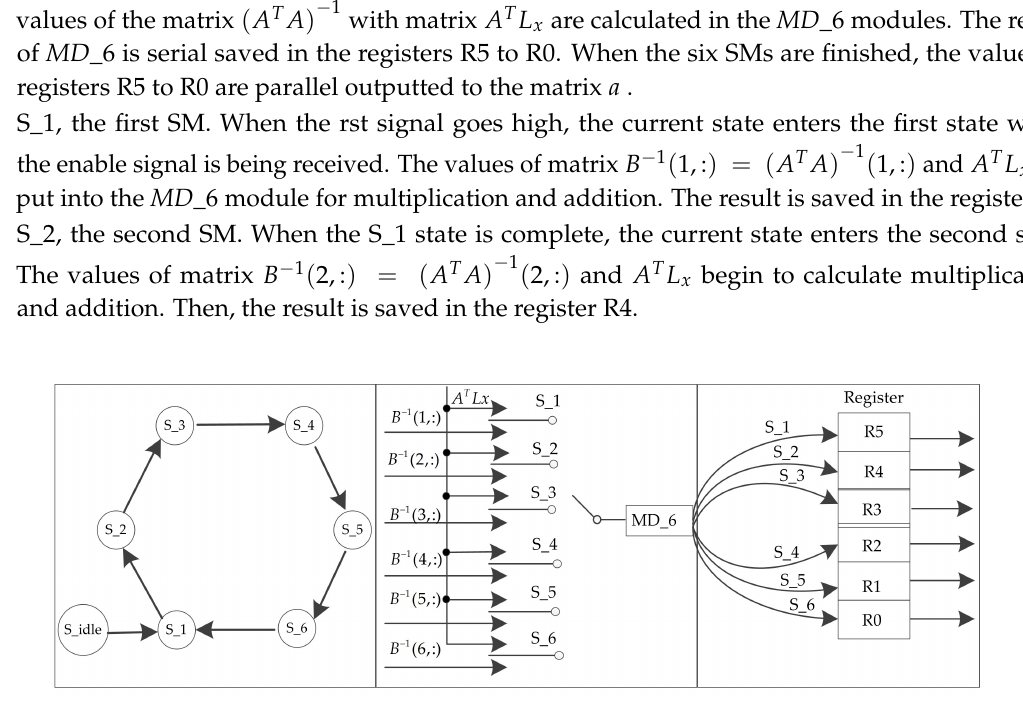
+ M − 1 L − 1 N − 1 matrix. ( b ) Solve M − 1 11 11 21 21 L − 1 matrix. 22 21